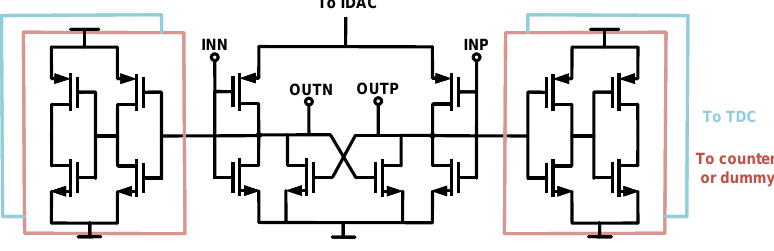
Figure 11. Circuit of the RO delay cell.